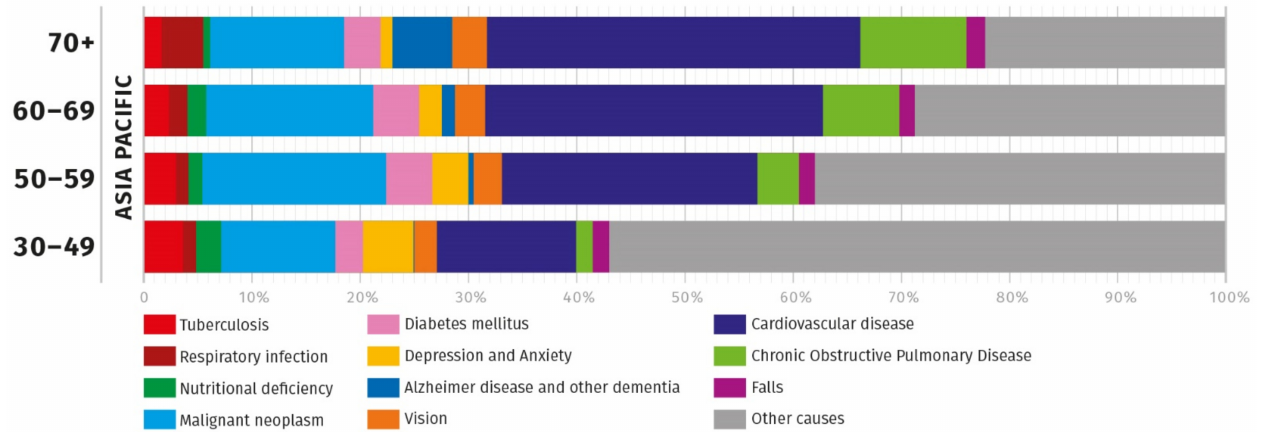
Figure 2. Top causes for DALY in the Asia-Pacific region per age group [3]. Asia-Pacific data were based on weighted arithmetic means by population between data from the Southeast Asia Region and the Western Pacific Region. Some causes were combined to group the relevant GHE codes—for example, “vision” is a sum of five visual organ disorders under ‘sensory organ disorders’ with GHE codes